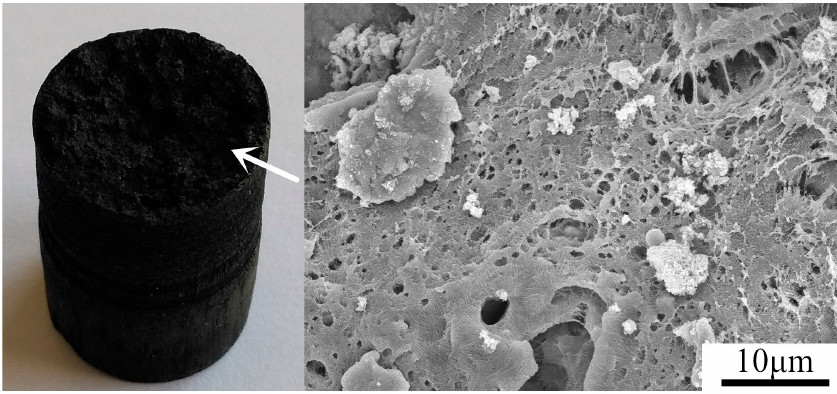
Figure 9. Residual sample and SEM micrographs of reaction surface after test No. 2. The arrow indicates the reaction surface.